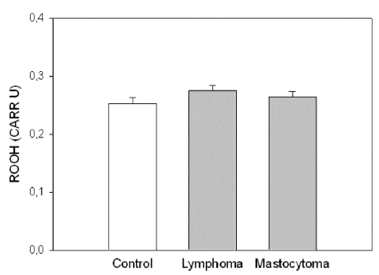
Figure 3. Hydroperoxide levels expressed as Carratelli Units (CARR U). Healthy dogs (control, n = 24), multicentric lymphoma (lymphoma, n = 11), primary cutaneous MCT (mastocytoma, n = 14).